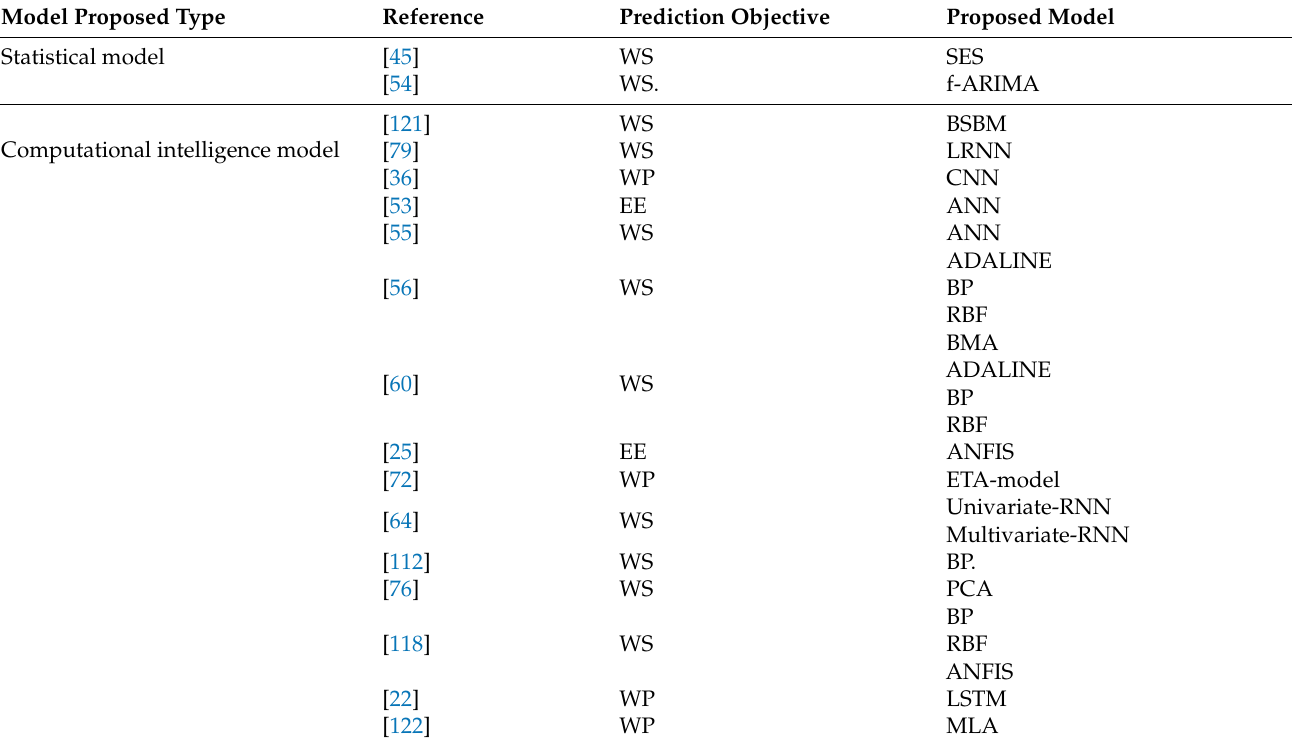
Table 6. Model Forecast Type